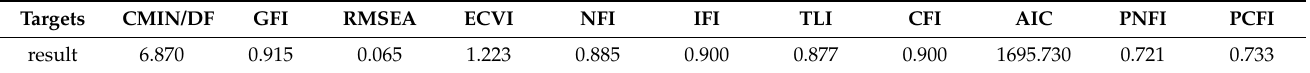
Table 5. Calculated results of the modified model fit index.